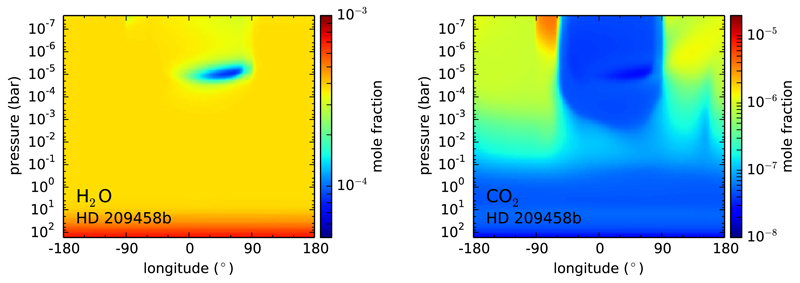
Calculated distributions of H2O and CO2 as a function of longitude and pressure in the atmosphere of HD 209458b, from Agúndez et al. (2014a). Note that H2O maintains a rather homogeneous distribution while CO2 experiences important abundance variations with longitude and height